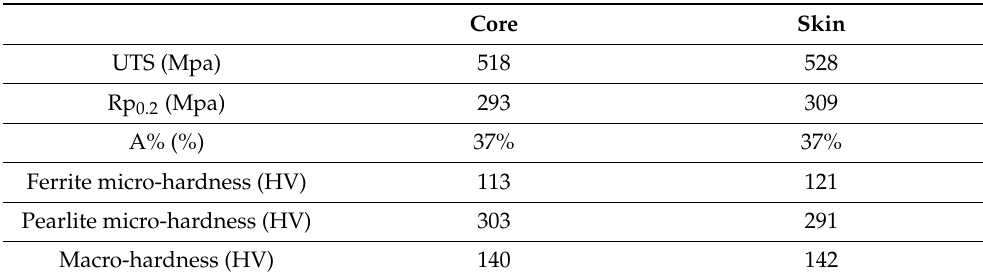
Table 6. Monotonic test results. Average values from three tests for tensile tests and tens of tests for hardness in each batch (core or skin).